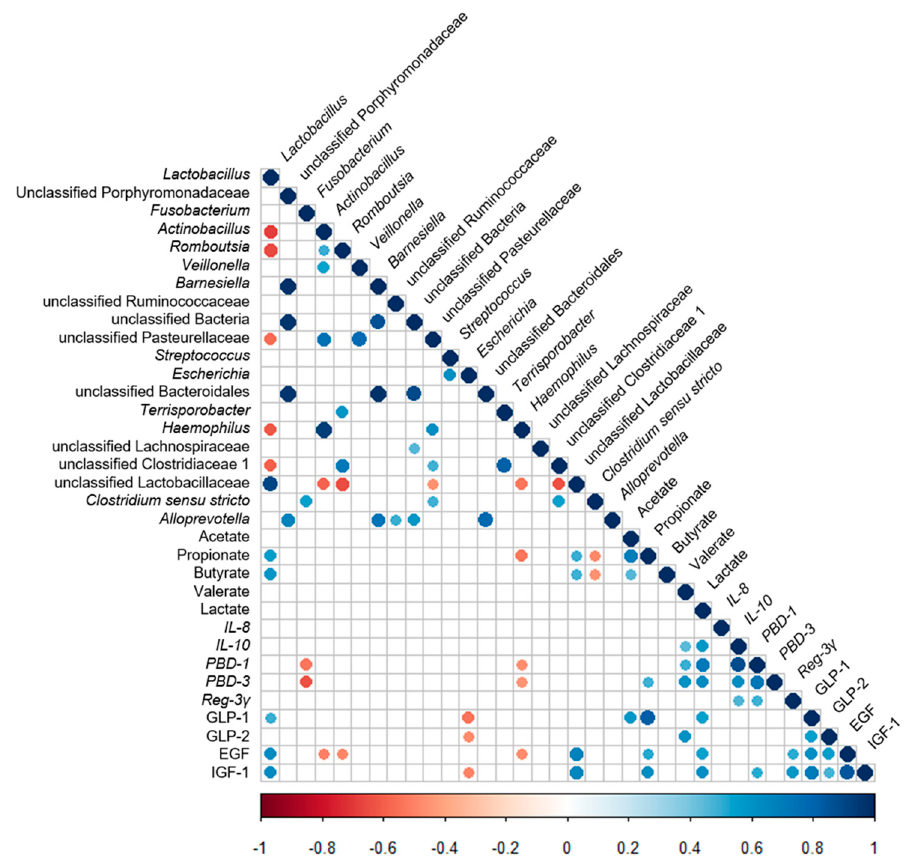
Figure 6. Correlation analysis between the ileal microbiota and the metabolites, the ileal cytokines’ expression, antimicrobial peptides’ expression, and ileal endocrine peptides levels. The R package of “corroplot” was used for generating the heat maps. The blue represents a significant positive correlation, and the red represents a significant negative correlation.